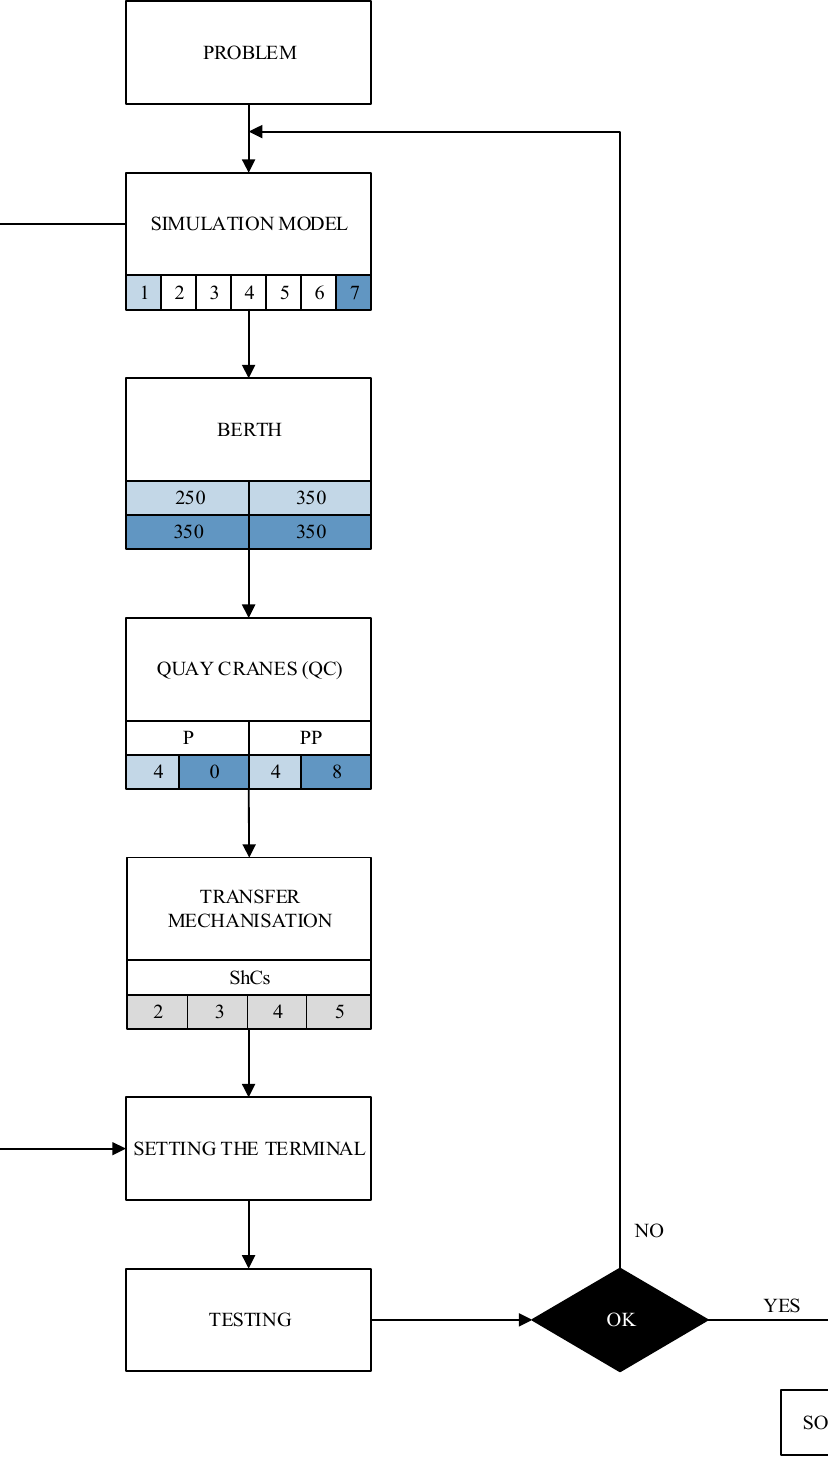
Figure 3. Simulation performance sequence (light blue—characteristics of the 1st scenario; dark blue—characteristics of 7th scenario).